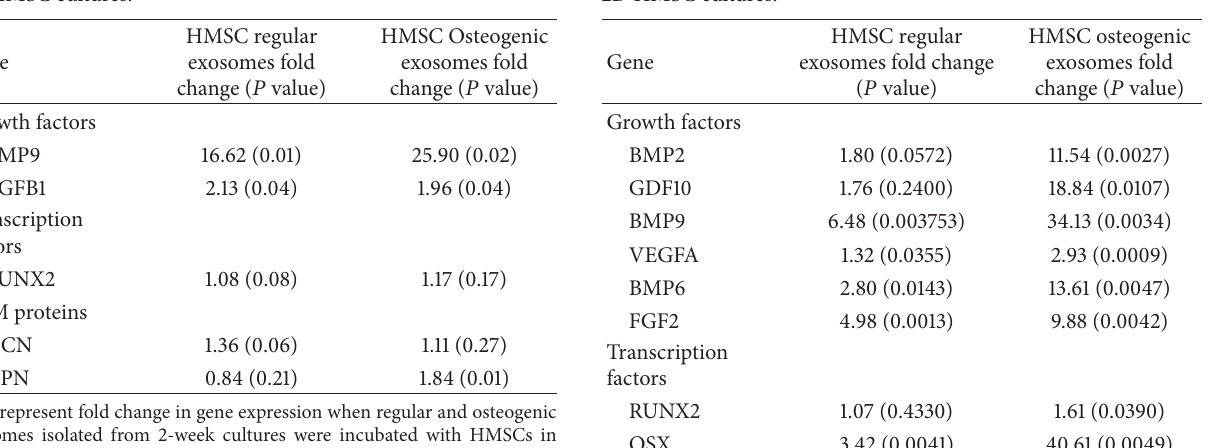
Table 2: Two-week exosome mediated change in gene expression: 2D HMSC cultures.